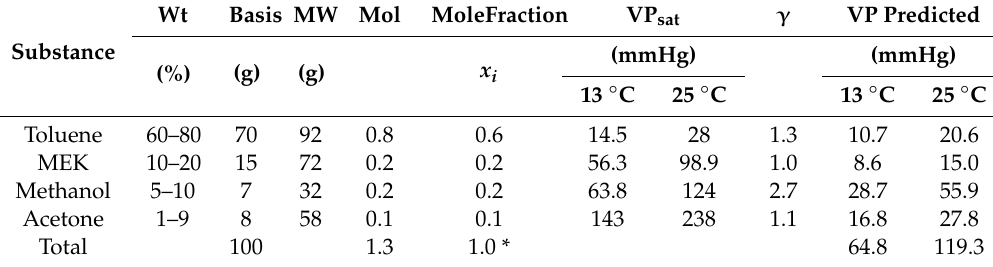
Table 1. Predicted Vapor Pressure for Components in the Mixture at 13 ◦ C.